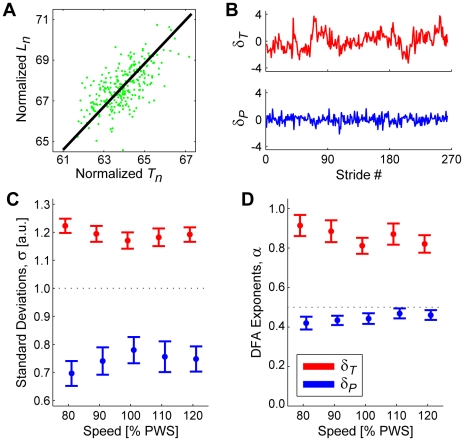
GEM decomposition results.(A) Example GEM data from a typical subject. Individual dots represent individual strides. The diagonal line represents the GEM (see Fig. 2). (B) Time series of δT and δP deviations for the data set shown in (A). Qualitatively, the δT deviations exhibit larger amplitudes and also appear to show greater statistical persistence than the δP deviations. (C) Standard deviations for all δT and δP time series at all 5 walking speeds. Error bars represent between-subject ±95% confidence intervals. Subjects exhibited significantly greater variability along the GEM (δT) than perpendicular to the GEM (δP): F(1,16) = 139.93; p = 2.53×10−9. (D) DFA α exponents for all δT and δP time series at all 5 walking speeds. Error bars represent between-subject ±95% confidence intervals. Subjects exhibited significantly greater statistical persistence along the GEM (δT) than perpendicular to the GEM (δP): F(1,16) = 368.21; p = 1.81×10−12. Additionally, all subjects exhibited significant anti-persistence (95% confidence interval upper bounds all <½) for the goal-relevant δP deviations at all 5 walking speeds.